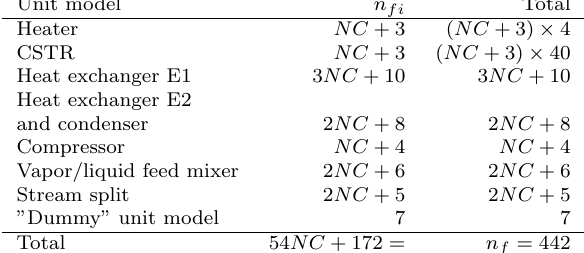
Table 2: Reformer model equations Figure 3: Nominal flows and temperature in